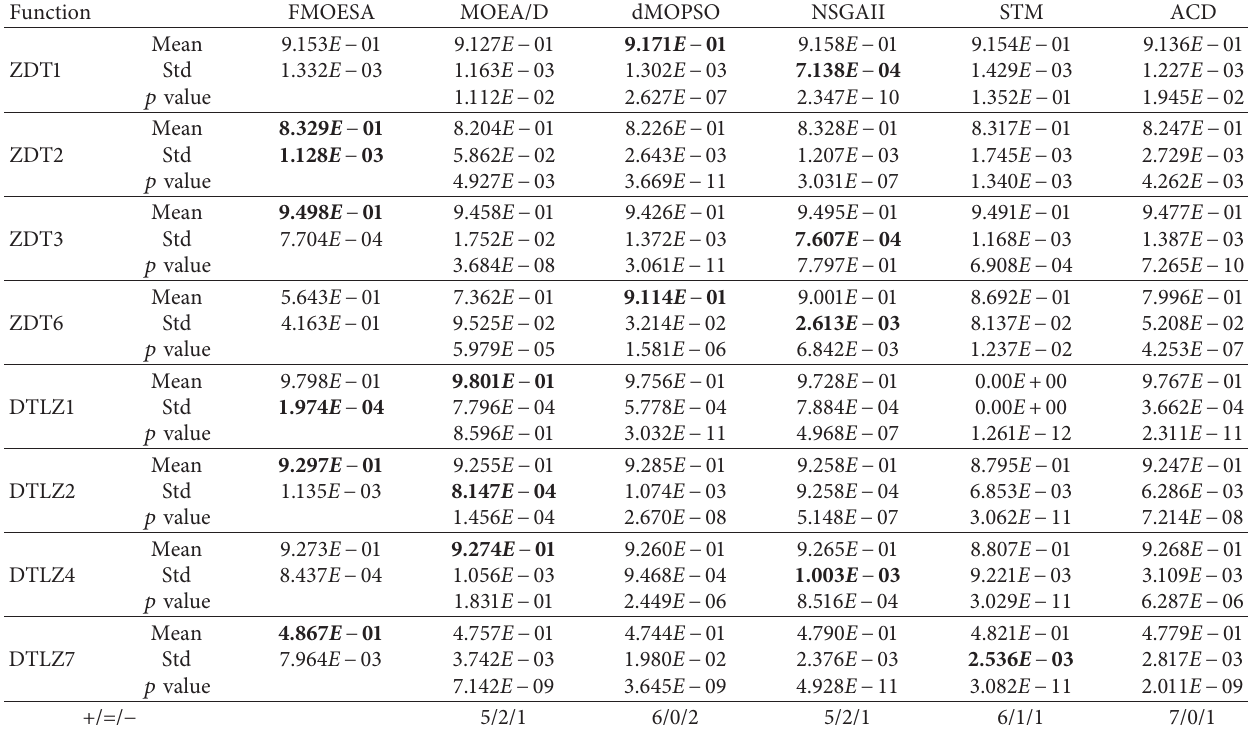
Table 3: HV results on the eight